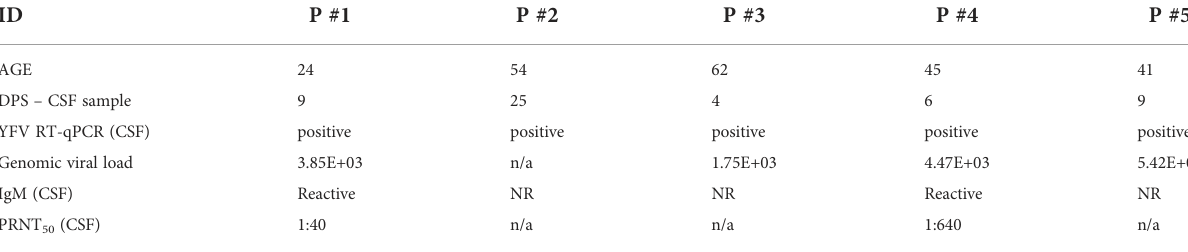
TABLE 1 Laboratory results of patients with detection of YFV RNA in